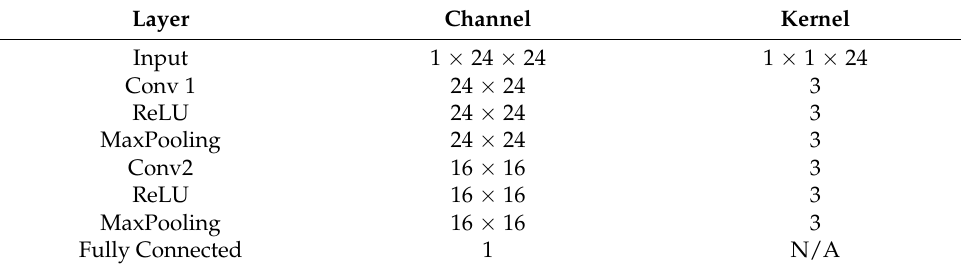
Figure 9. Proposed detecting anomaly method using time series images. Table 2. CNN-based model structure for binary classification. Table 2. CNN-based model structure for binary classification.